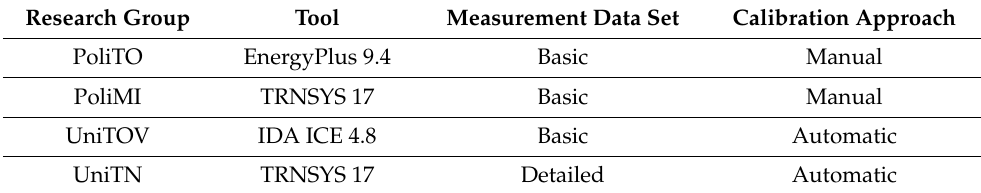
Table 1. Settings of the